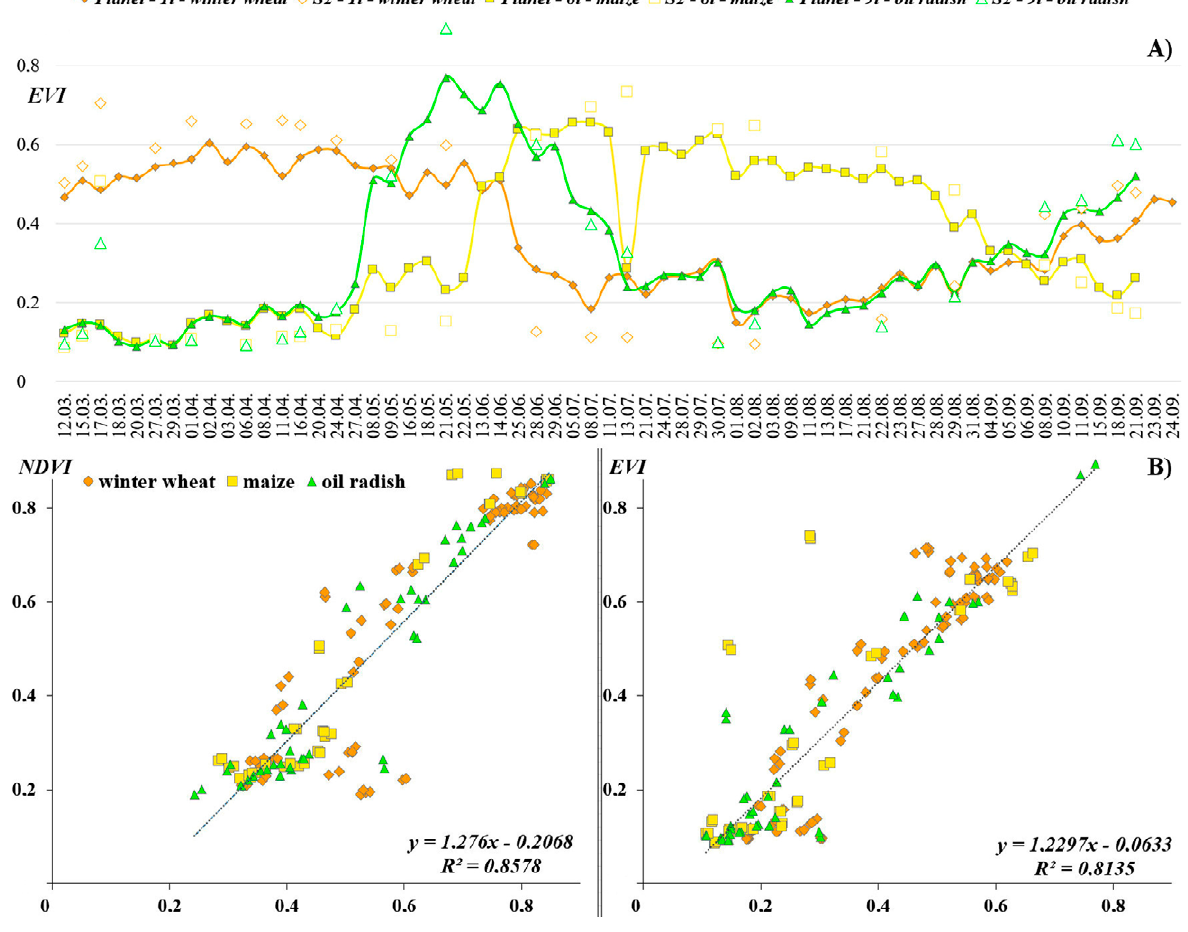
Figure 10. EVI time series of Planet and Sentinel-2 satellites for different crops in summer 2020 (A), and linear regression analysis based on EVI and NDVI for this period